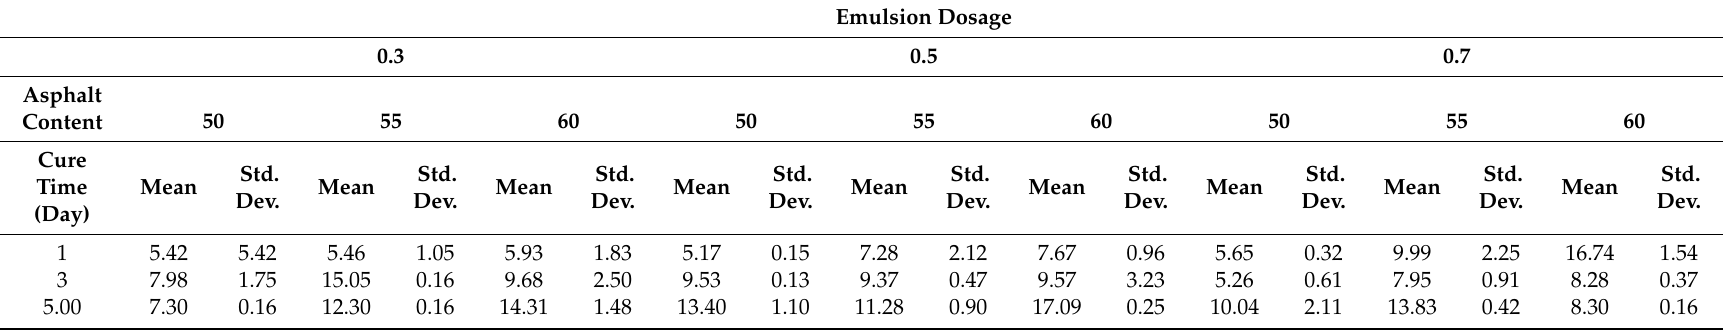
Table 4. Summary statistics for the fracture energy (J / m 2 ) of the slow setting asphalt emulsions for the three doses and cure